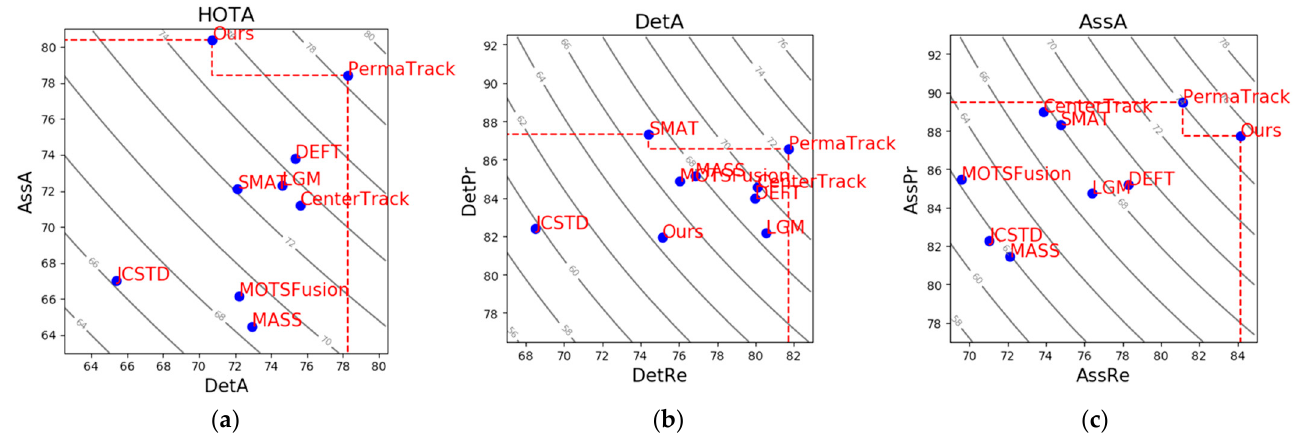
Figure 6. Comparison results between our method and eight state-of-the-art methods on HOTA sub- metrics. ( a ) HOTA is decomposed into DetA and AssA to evaluate the detection and data association performance of MOT methods. ( b ) DetA is decomposed into DetRe and DetPr to evaluate the detection performance. ( c ) AssA is decomposed into AssRe and AssPr to evaluate the data association performance. The grey curves are level sets contours of a constant score.